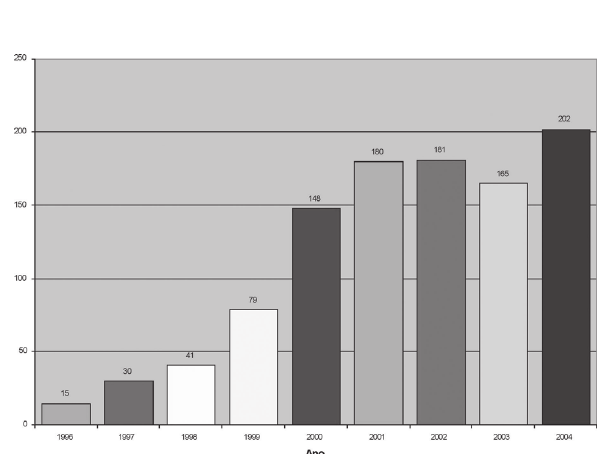
Fig. 1 - Distribuição anual dos corações recebidos no BVCHSC entre setembro de 1996 e Dezembro de 2004